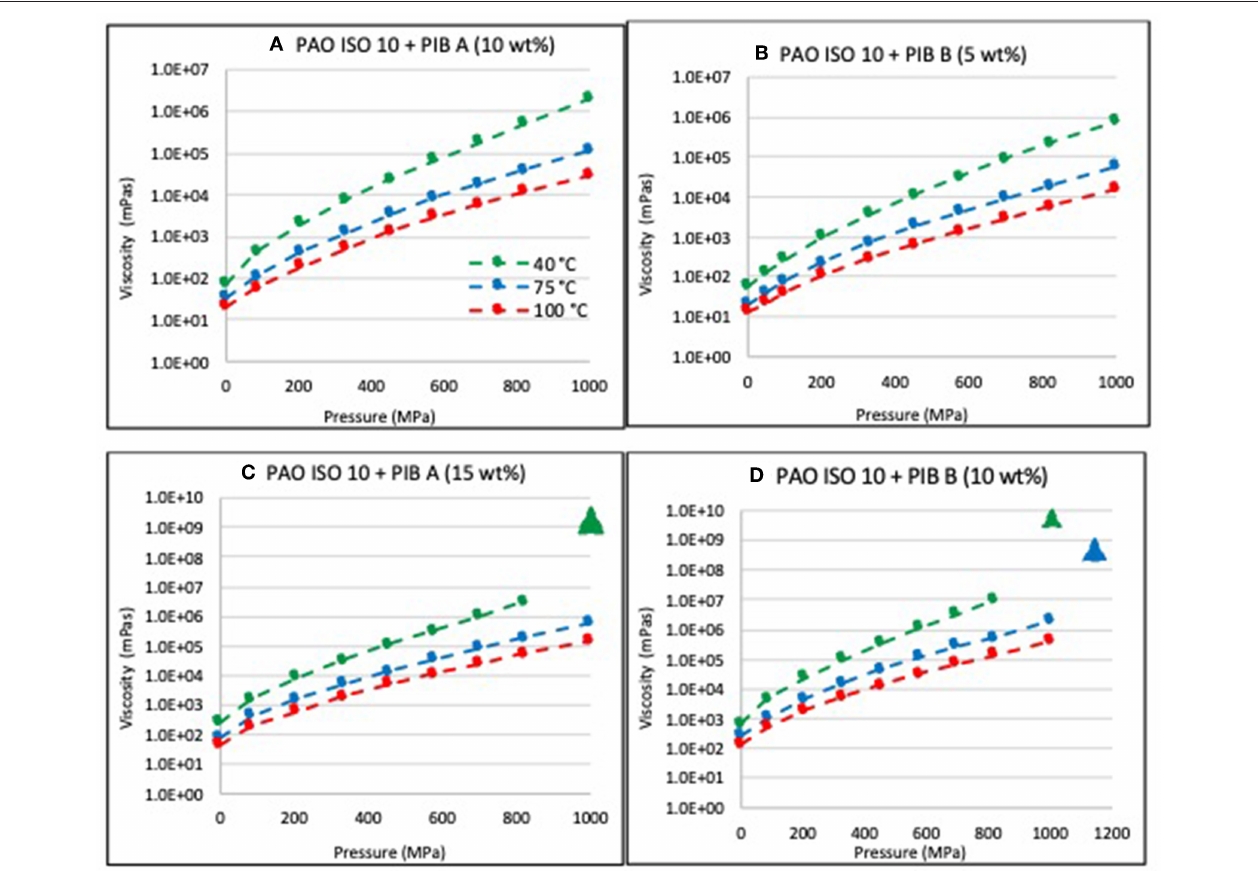
FIGURE 3 | Viscosity (mPa-s) as a function of pressure and temperature for (A) mixture of PAO ISO 10 and PIB A (10 wt%), (B) mixture of PAO ISO 10 and PIB B (5 wt%), (C) mixture of PAO ISO 10 and PIB A (15 wt%), and (D) mixture of PAO ISO 10 and PIB B (10 wt%). The triangle symbols indicate the lowest estimate of viscosity corresponding to the pressure where movement of the sinker